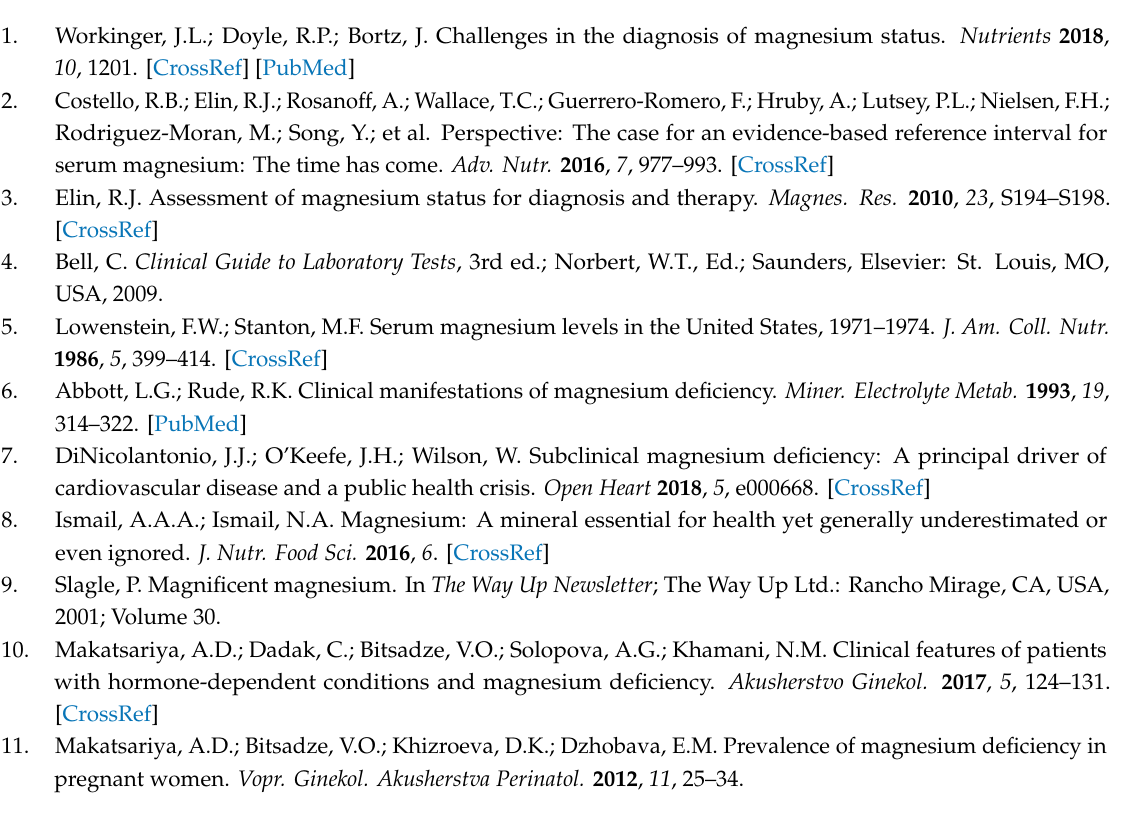
Table S1: Diagnostic utility of MDQ using a serum magnesium level cut-o ff of 0.8 mmol / L, Table S2: Diagnostic utility of MDQ using a serum magnesium level cut-o ff of 0.66 mmol / L, Table S3: Development of MDQ-23, Table S4: Development of